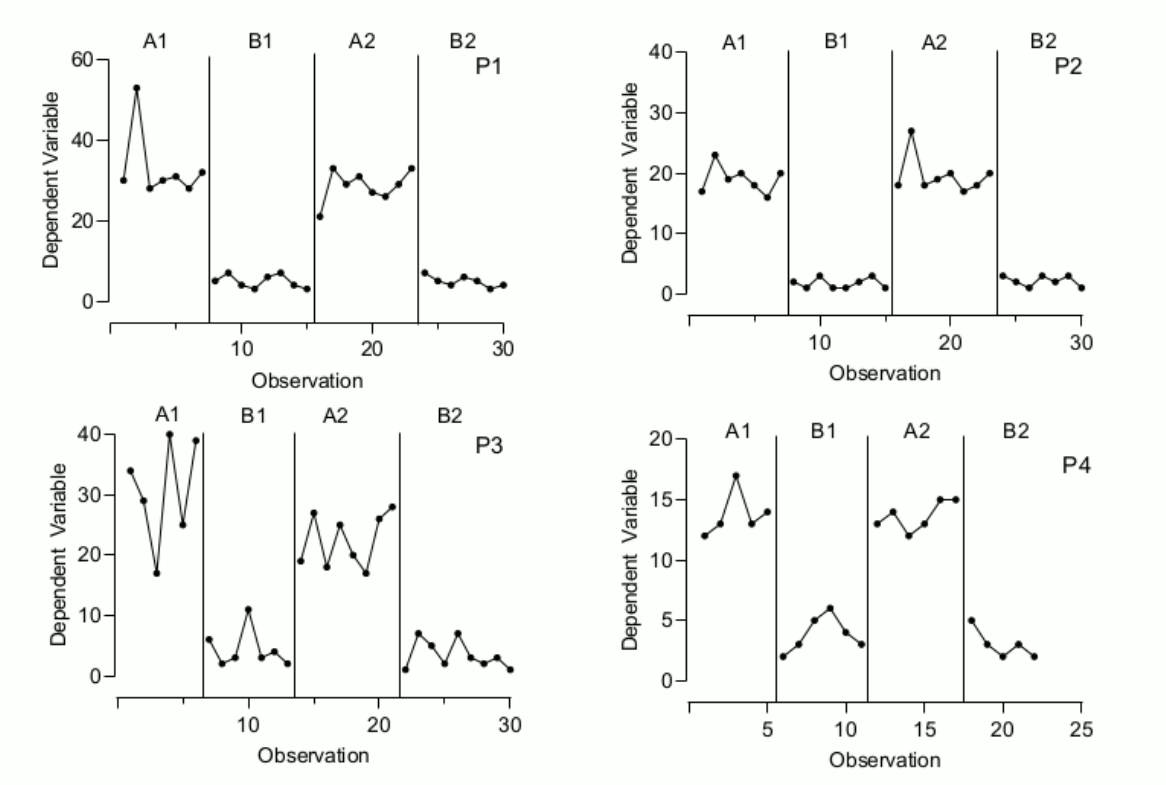
subjects. A1 = First Baseline, B1 First Treatment, A2 = Return to Baseline, B2 = Return to Treatment. P1–P4 represent different hypothetical